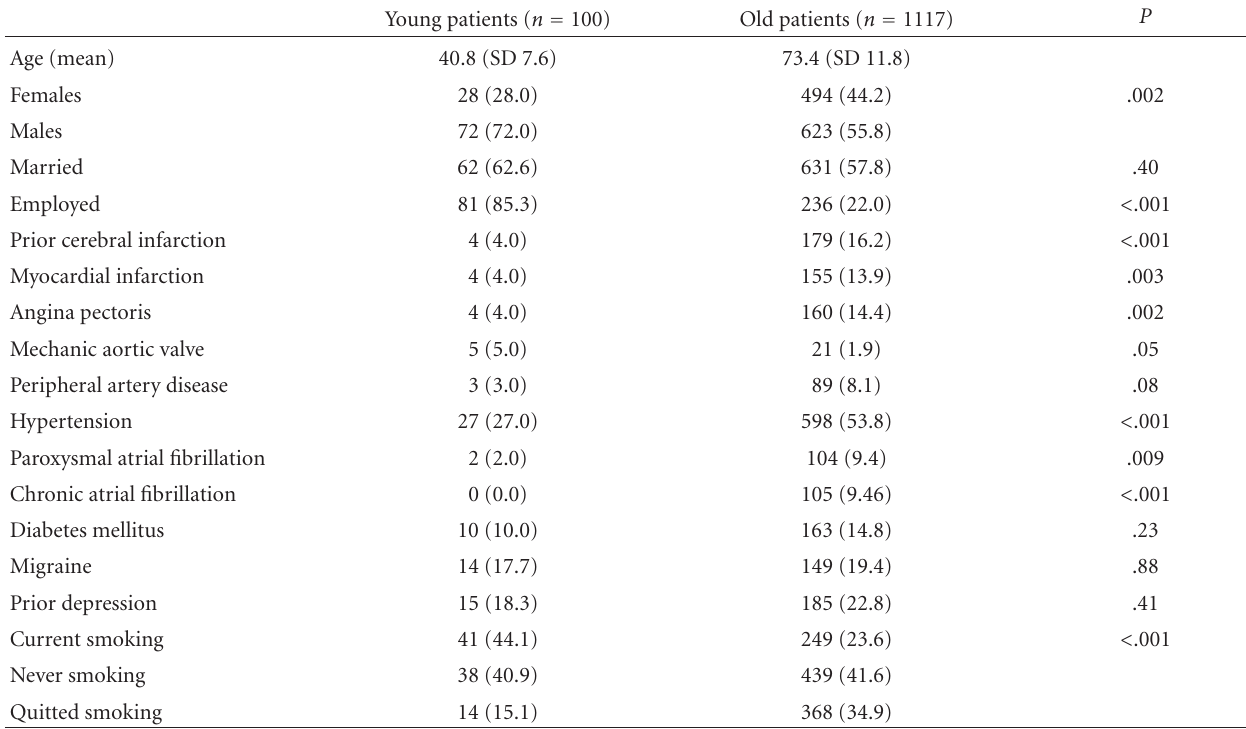
Table 1: Demography of young and old patients with cerebral infarction, based on patient history recorded on